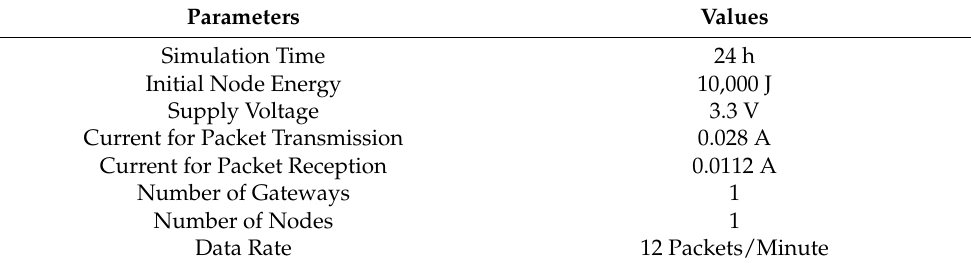
Table 2. Simulation